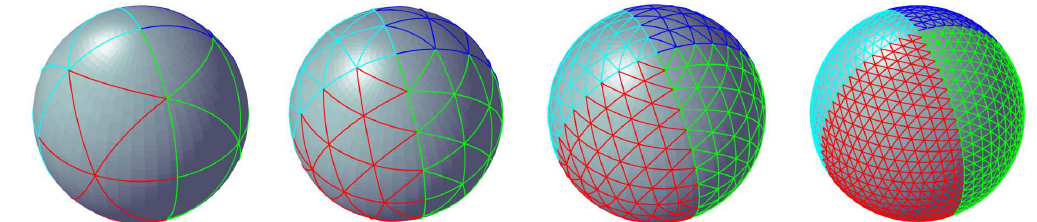
Figure 13. Four-fold DGGSs based on the octahedron version of SACs (level = 1, 2, 3,